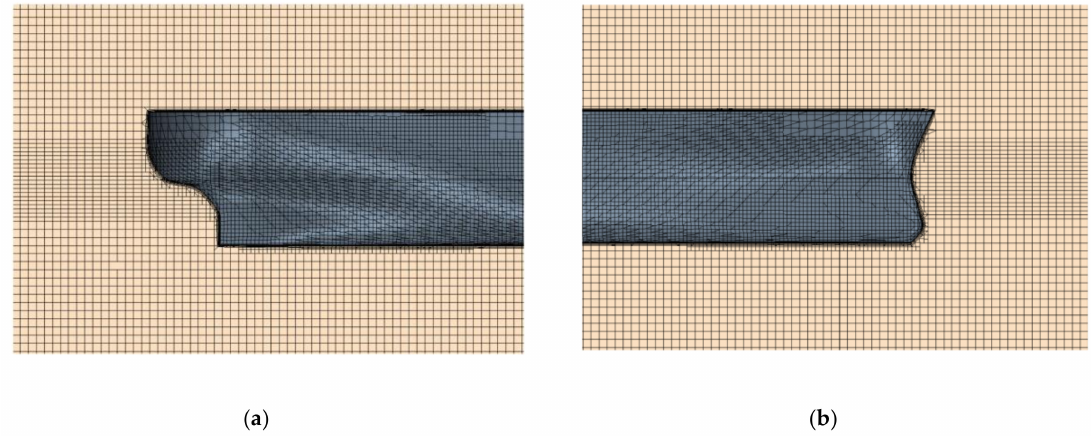
Figure 8. Boundary layer mesh around hull surface at bow and stern: ( a ) stern; ( b ) bow.